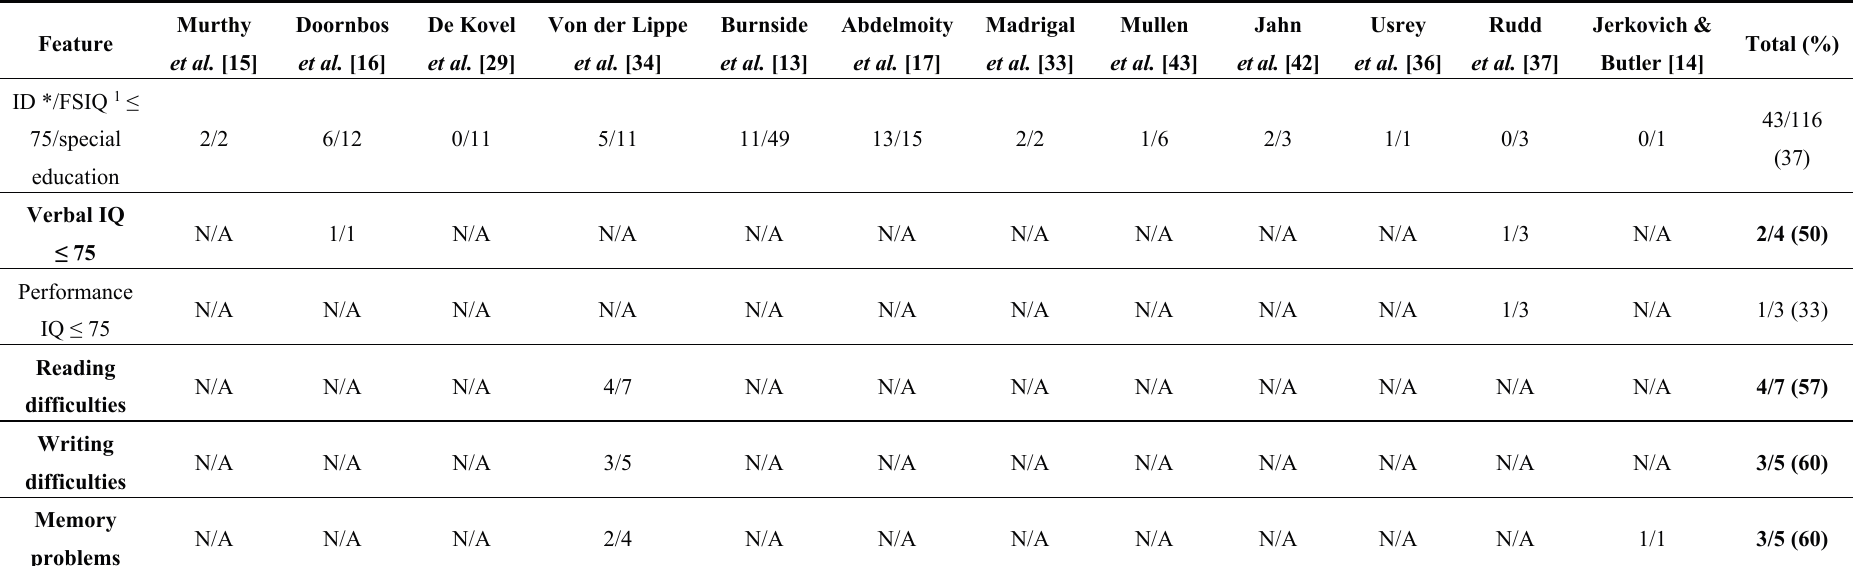
Table 3. Literature Review of Intelligence and Academic Achievement for Individuals with Chromosome 15q11.2 BP1–BP2 Microdeletion